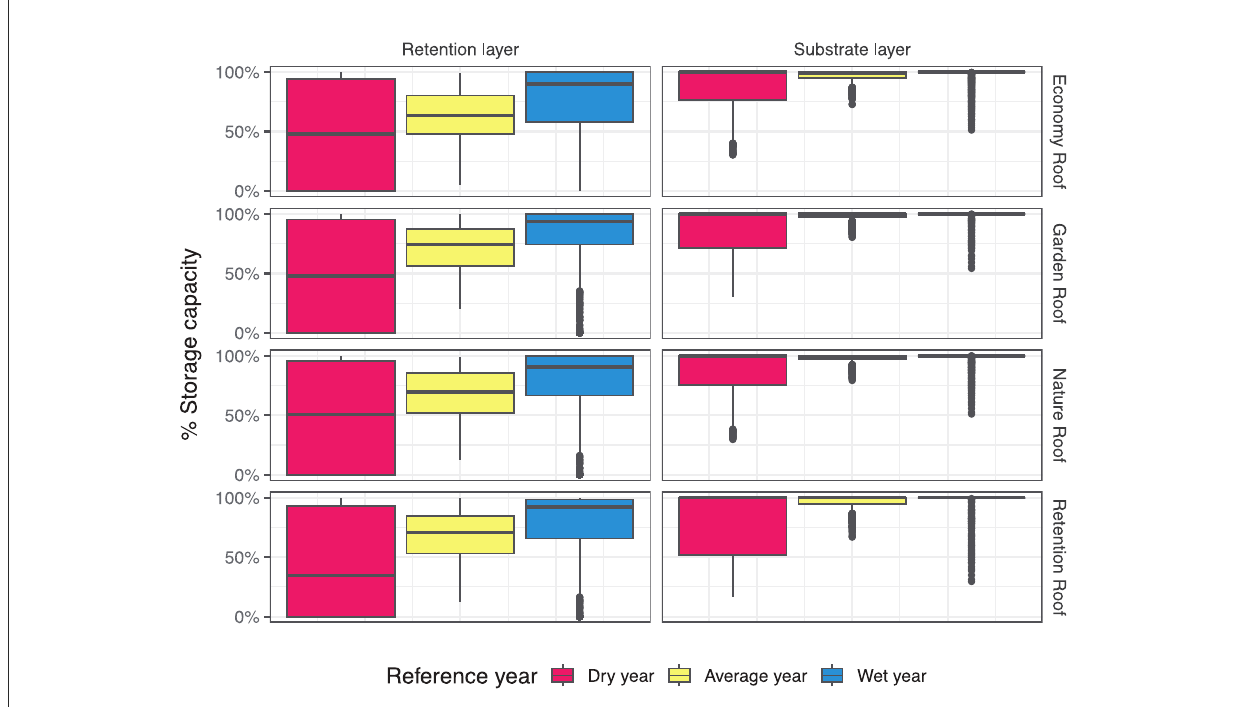
FIGURE6 Boxplots of distribution of predicted relative storage capacity for all four green roof types for the extreme dry, average, and extreme wet reference years for the retention and substrate layer, respectively. GR2L was run with calibrated parameters for each green roof